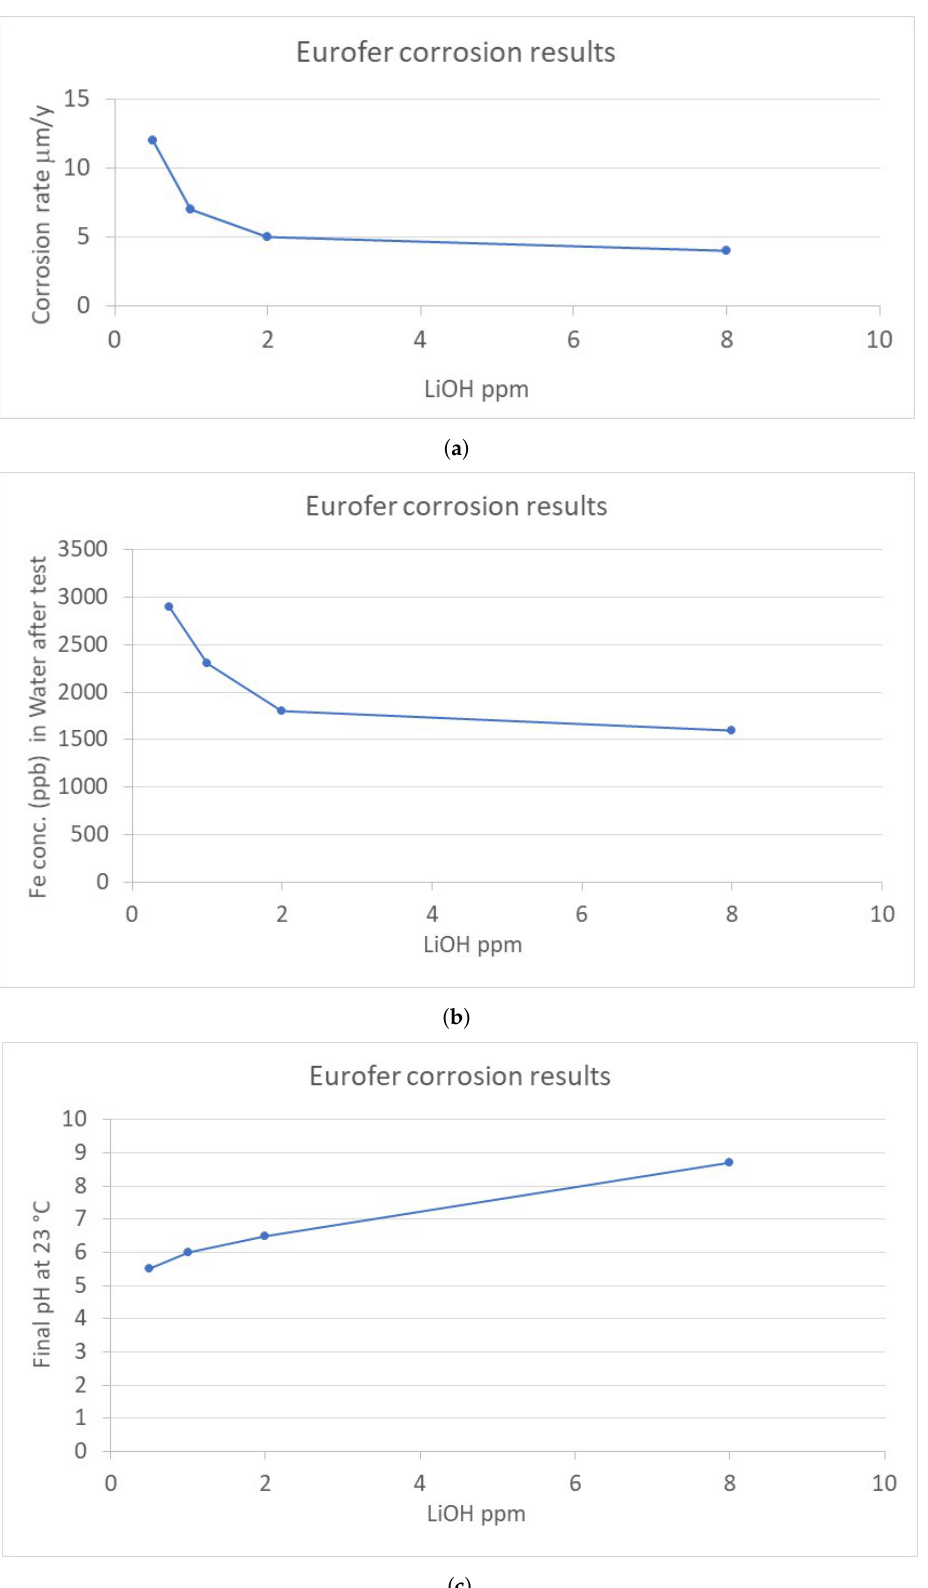
Figure 3. Summary of the EUROFER corrosion results performed in autoclave and corrosion loop (HTHP) facilities: ( a ) EUROFER corrosion rate as a function of LiOH concentration. Corrosion rate data were calculated on the base of weight loss measurements, according to the ASTM G1 procedure. ( b ) Diagram of the iron concentration versus LiOH concentration. ( c ) Correlation of the final water pH measured at RT as a function of LiOH